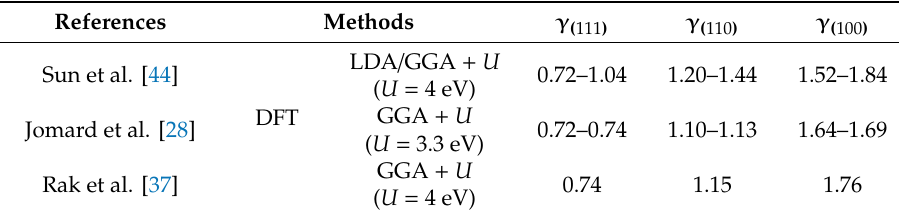
Table 3. PuO 2 surface energies in units of J / m 2